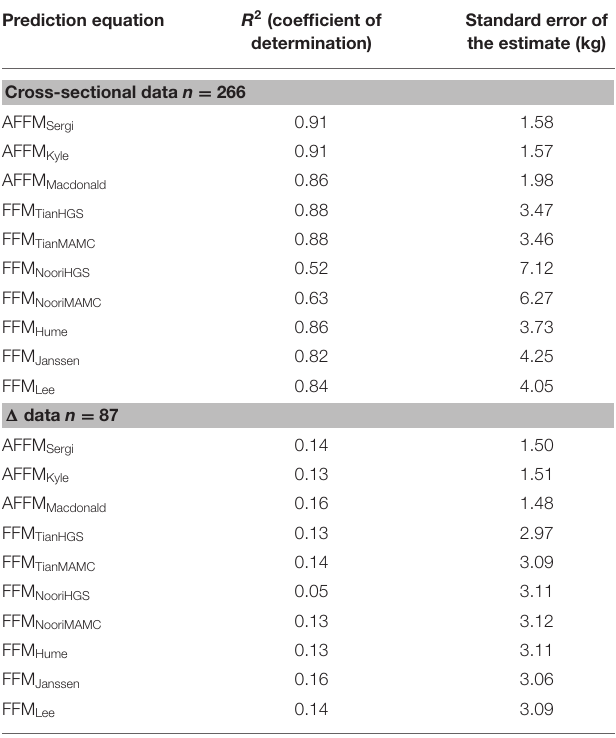
AFFM, appendicular fat free mass; FFM, fat free mass.